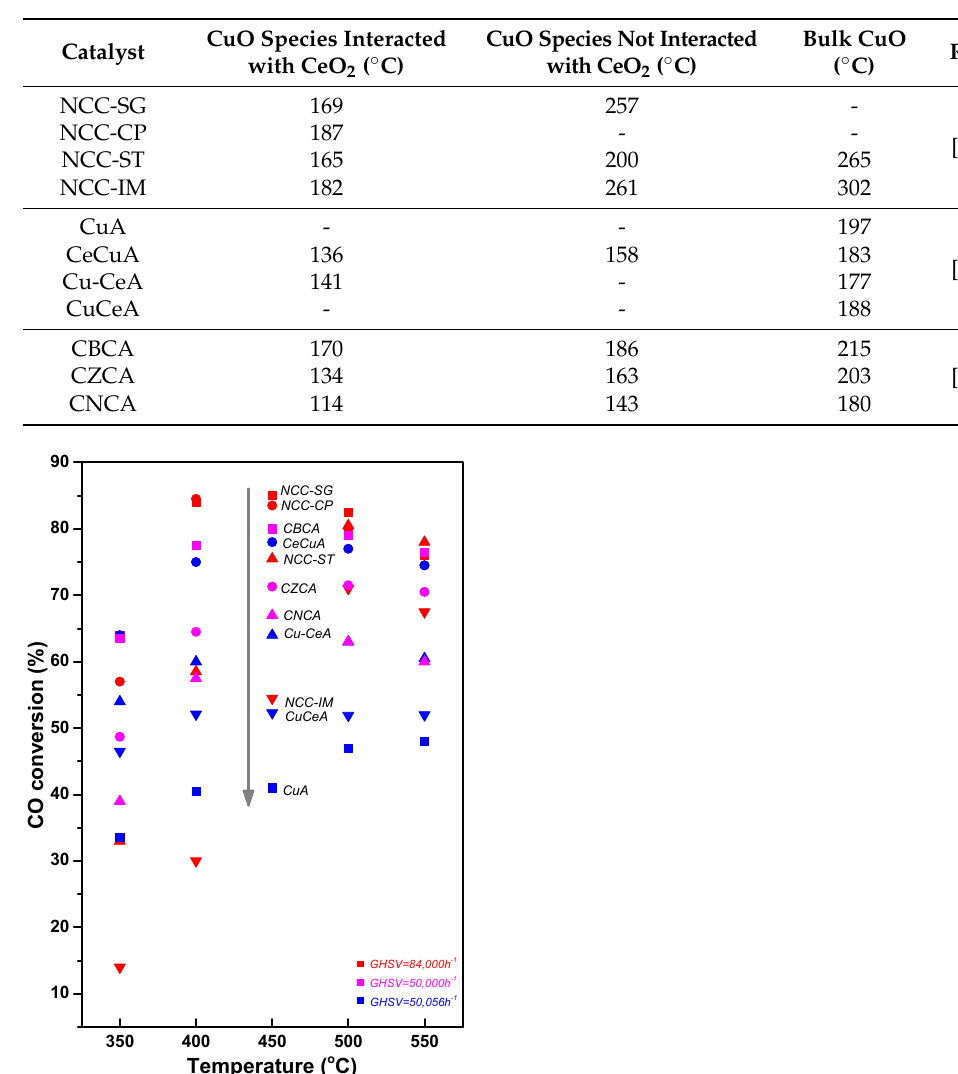
Table 6. Reduction Temperature of Cu-based catalysts.